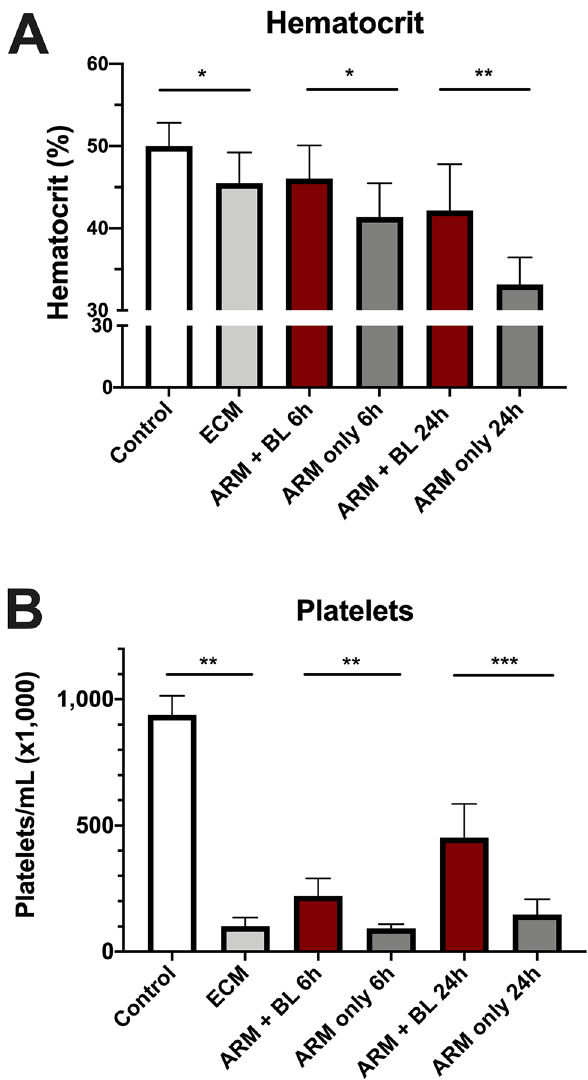
Figure 1. Effect of artemether treatment with and without 200 μL of whole blood on hematocrit level and platelet counts. Plasmodium-berghei ANKA-infected mice showing signs of ECM on day 6 of infection (n = 6–11 per group) received artemether (ARM) 20 mg/kg (20 μL) given IP, and mice in one of the groups also received 200 μL of whole blood (BL) also given IP. ( A ) Hematocrit: mice with ECM before treatment showed a mean 9% decrease in hematocrit in relation to uninfected controls (45.5 ± 3.72% versus 50.0 ± 2.83%, P = 0.0345). Treatment with ARM led to further decreases in hematocrit after 6 and 24 h (41.4 ± 4.10% and 33.2 ± 3.72%). Whole blood transfusion given together with ARM prevented the decrease in hematocrit at 6 h (ARM + BL: 46.0 ± 4.06%; ARM only: 41.4 ± 4.10%, P = 0.0352) and provided substantial protection for the strong decrease in hematocrit at 24 h (ARM-BL: 42.2 ± 5.63%; ARM only: 33.2 ± 3.72%, P = 0.0015, versus). ( B ) Platelet count: platelet count was drastically reduced by nearly 90% in mice with ECM compared to uninfected controls (101 ± 33.9 versus 938 ± 75.2, P = 0.0012). Treatment with ARM only did not change platelet levels within 6 h and 24 h. Whole blood transfusion given together with ARM led to significant recoveries in platelet counts compared to ARM only-treated mice at 6 h (221 ± 68.8 versus 93 ± 16.5, P = 0.0061) and 24 h (451 ± 134.5 versus 147 ± 59.9, P = 0.0004). Data are shown as mean ± standard deviation and Student t-test was performed for statistical analyses comparing two